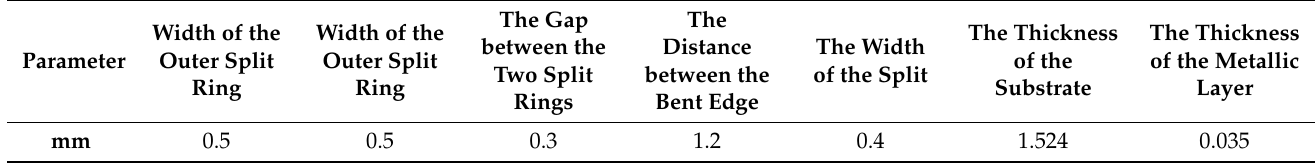
Table 1. The parametric specifications for the proposed resonator.